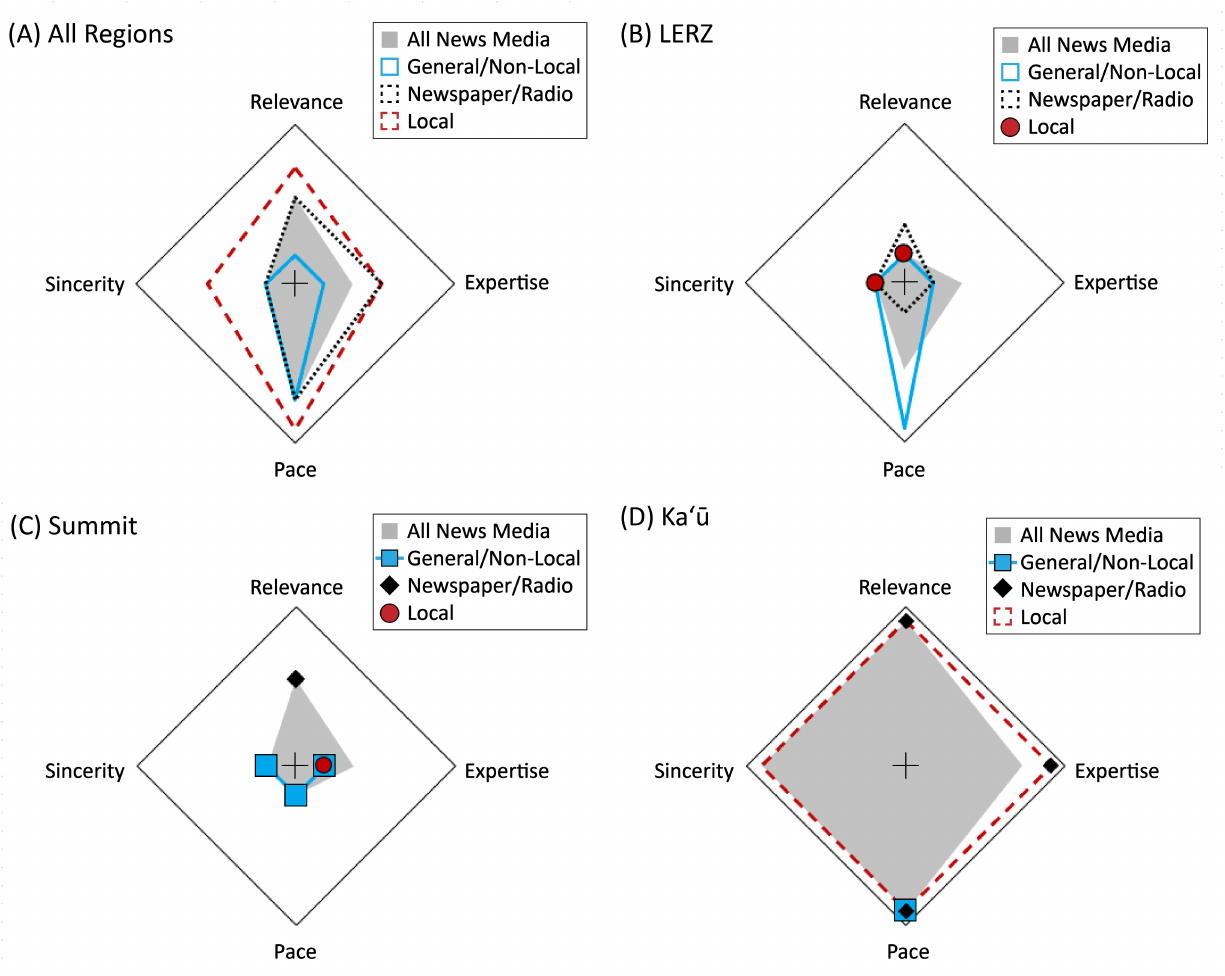
Figure 9: Radar charts illustrating participants’ perceptions of various news media organizations or channels. Gray shaded areas include commentary on all news media, while line plots provide comments regarding specific televised news organizations (i.e. non-local or local) or non-televised channels (i.e., newspaper or radio). Themes are plotted on a five-point scale: 1 = “consistently negative,” 2 = “mostly negative,” 3 = “mixed,” 4 = “mostly positive,” 5 = “consistently positive.” In lieu of axis tick marks (to avoid cluttering), the center of each chart is indicated with a +. Plots are left blank for themes lacking qualitative commentary; markers or open outlines plot the scores for the remaining themes. For specific scores, the reader is referred to Supplementary Material